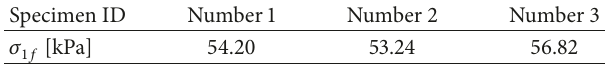
Table 1: Maximum vertical stresses 𝜎 1𝑓 (peak stress) for the three specimens.